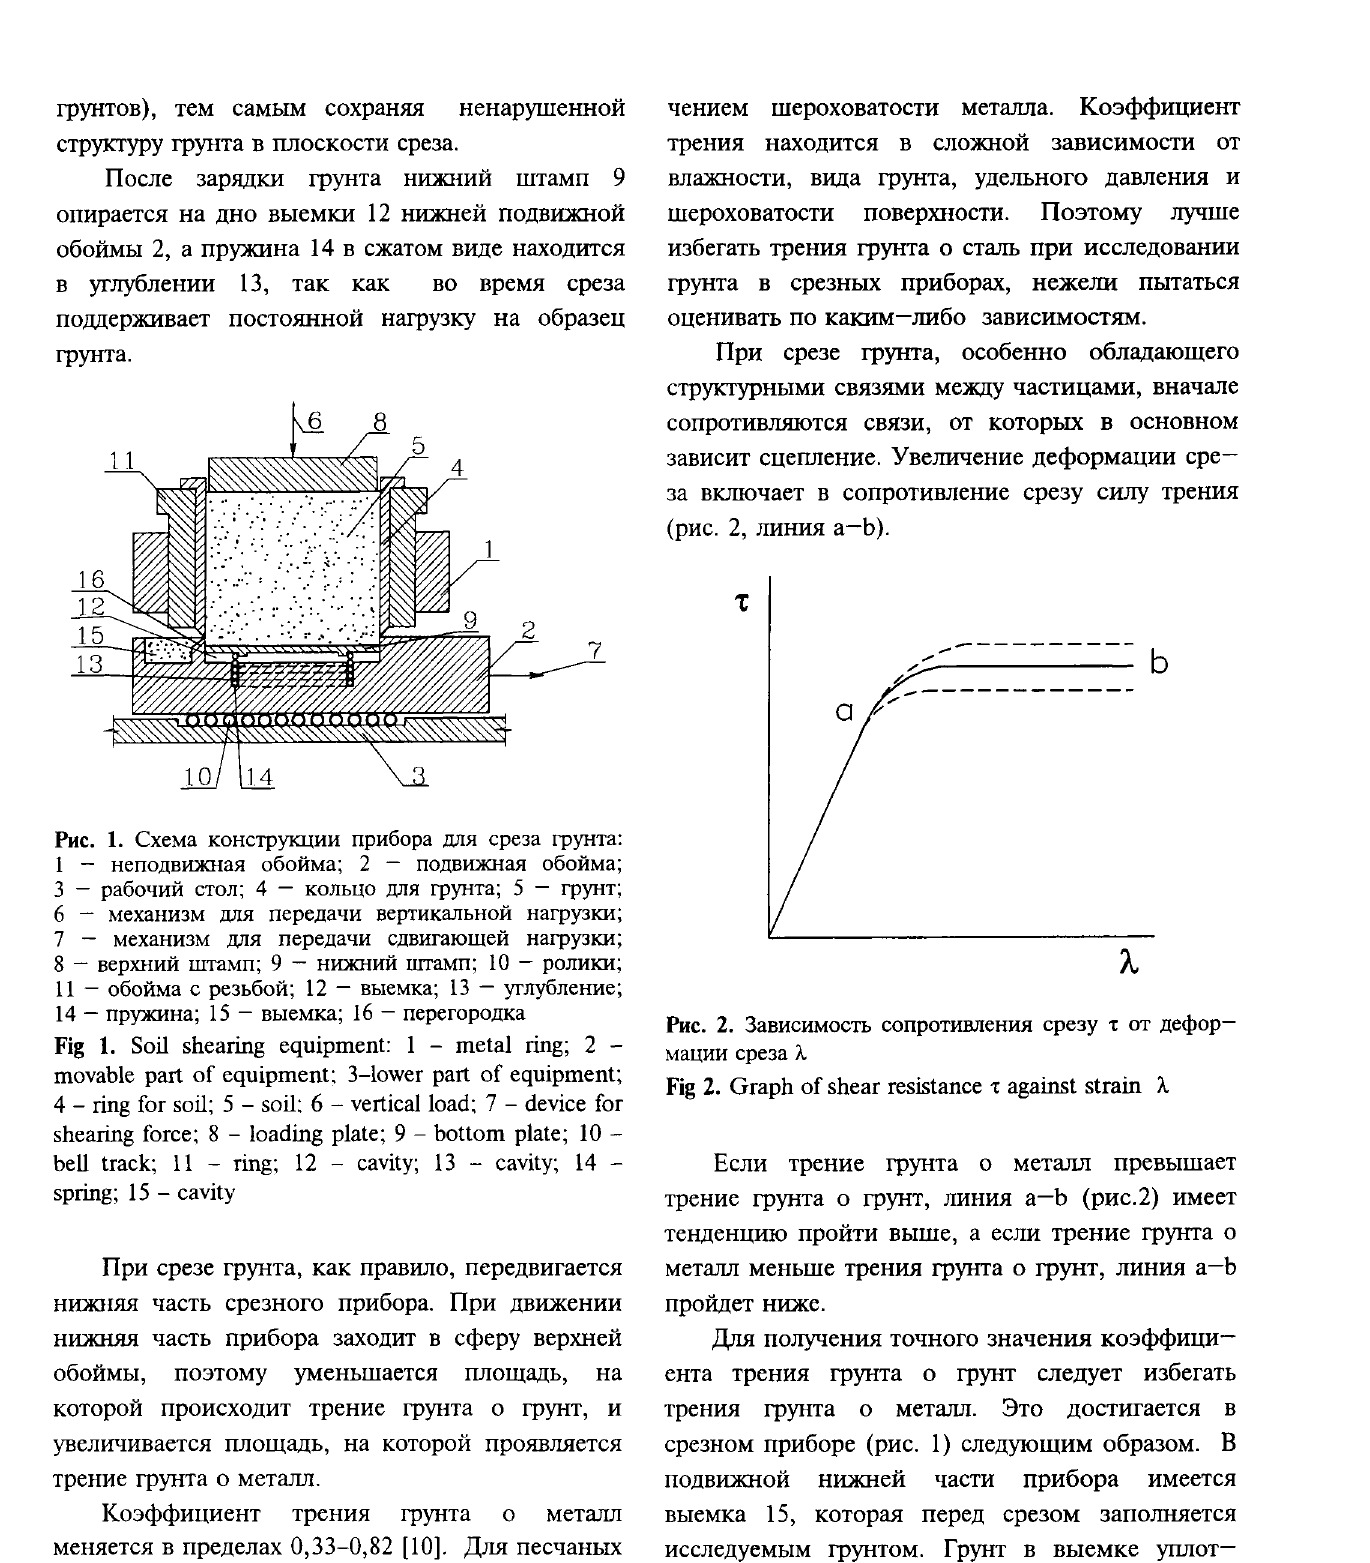
Fig 1. Soil shearing equipment: 1 - metal ring; 2 - movable part of equipment: 3-lower part of equipment; 4 - ring for soil; 5 - soil: 6 - vertical load: 7 - device for shearing force; 8 - loading plate; 9- bottom plate; 10 - bell track; 11 - ring; 12 - cavity; 13 - cavity; 14 -